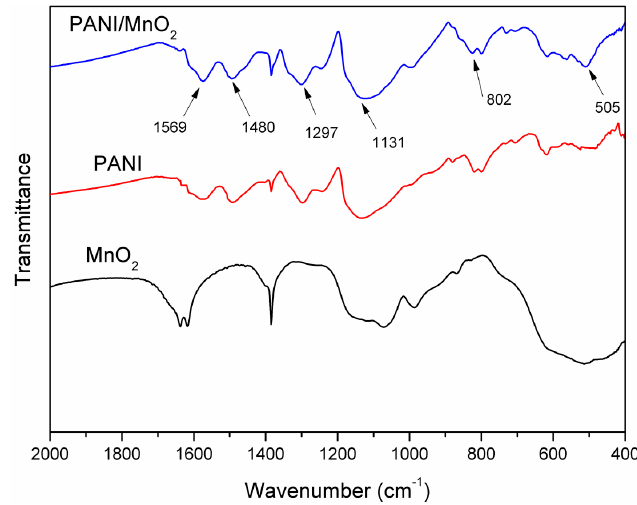
Figure 3. FT-IR spectra of PANI, MnO 2 and PANI/MnO 2 .